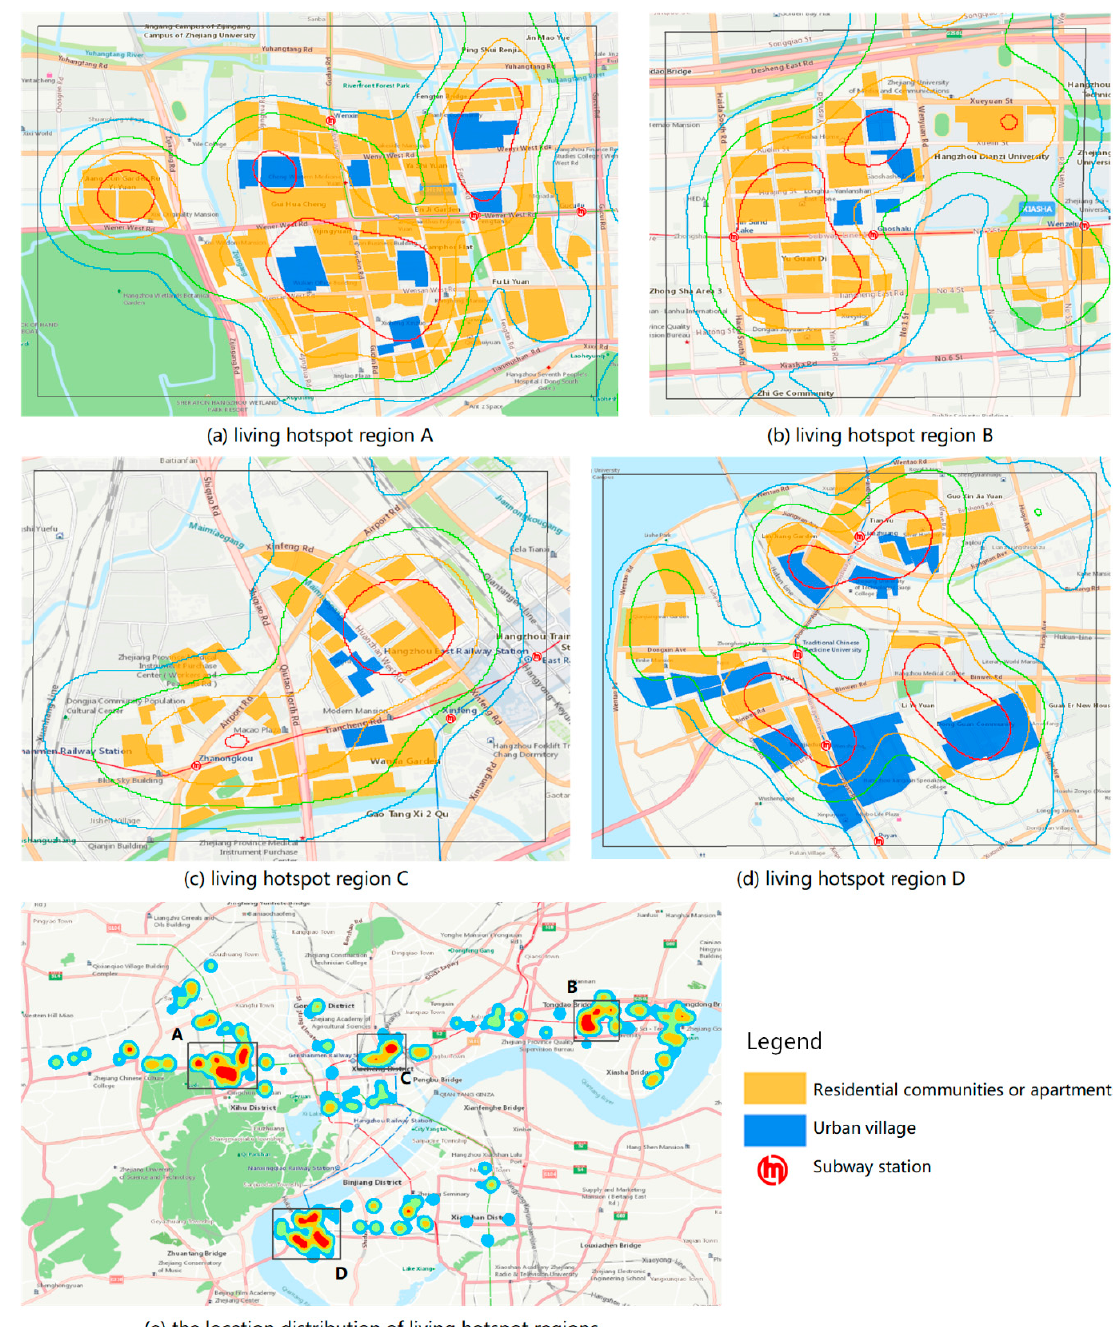
Figure16. Residentialcommunities, apartments, Figure 16. Residential communities, apartments, and urban villages in the hotspot regions of living areas.